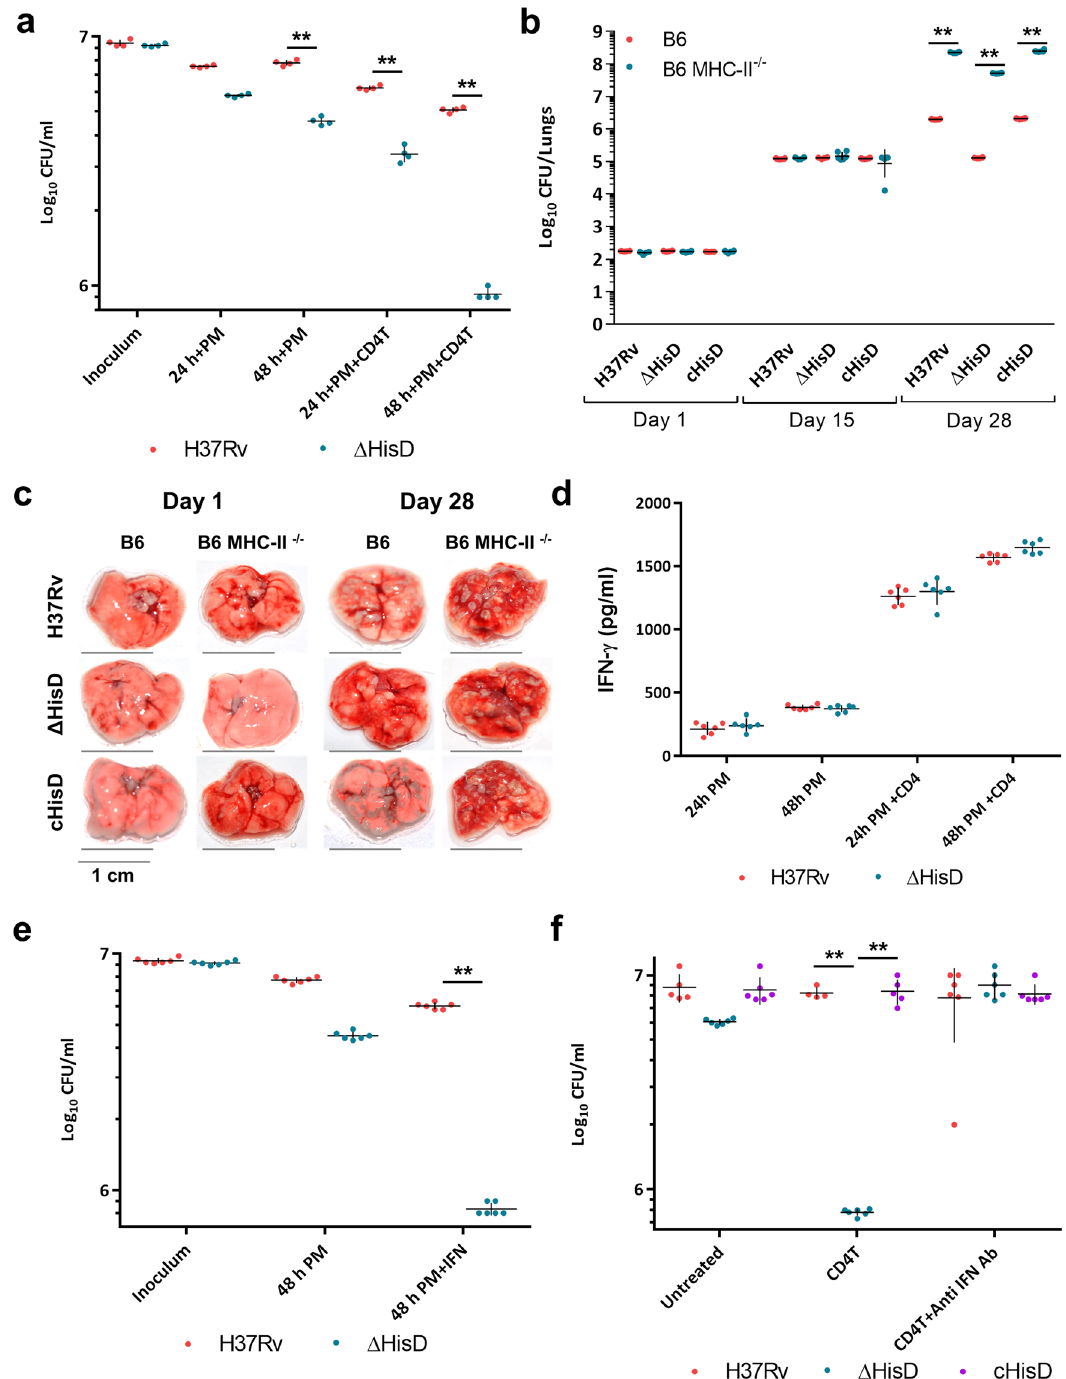
Fig. 4 A CD4 directed IFN- γ mediated bacillary clearance of Mtb histidine auxotroph. a Bacillary counts for Δ hisD are decreased by 10-fold compared to H37Rv at 48 h post-infection, suggesting a possible role of CD4 T-cell-based activation of macrophages in the enhanced clearance of Δ hisD ( n = 3 independently acquired and cultured primary cells; mean and SEM; ** P -value < 0.005). b The bacillary counts for H37Rv and c hisD each sharply rise as high as 10 8 and for Δ hisD as 10 7.5 on day 28 post infection in infected B6 MHC-II − / − mice lungs. ( n = 6 individual mice per time point; mean and SEM; ** P -value < 0.005). c A high degree of lung damage in the external pathophysiology is observed 28 days post infection with H37Rv, Δ hisD and c hisD in B6 MHC-II − / − null mice (pictures are representative of three individual mice lungs samples). d While un-stimulated macrophages show low titres of secreted IFN- γ , CD4 T cell activated macrophages show high levels of IFN- γ (1600 pg ml − 1 ) in culture medium 48 h post infection ( n = 6 measurements from independently acquired and cultured primary cells; mean & SEM). e External supplementation of IFN- γ (~3000 pg ml − 1 ) post infection onto infected primary macrophages led to equivalent decrease in bacterial counts of Δ hisD as in case of CD4 T cell activated macrophages ( n = 6 independently acquired and cultured primary cells; mean and SEM, ** P -value < 0.005). f Abrogation of the bactericidal activity post treatment with anti-IFN antibodies observed in CD4 T cell stimulated macrophages infected with Δ hisD ( n = 6 independently acquired and cultured primary cells; mean and SEM; ** P -value < 0.005).